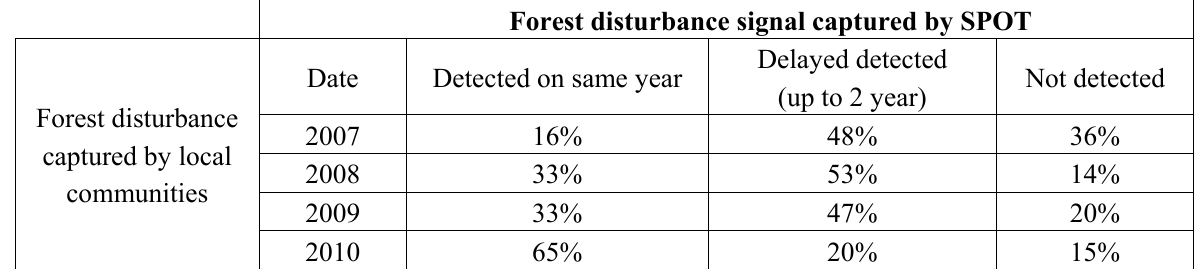
Table 4. Delay in capturing forest disturbance signal by SPOT